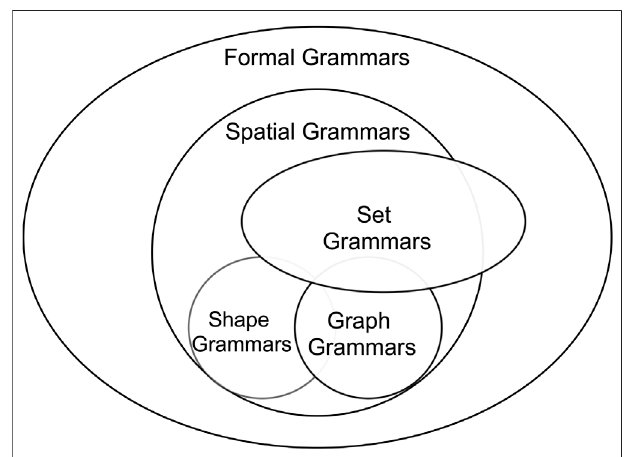
FIGURE 11 | Taxonomy of formal grammars utilized for engineering design